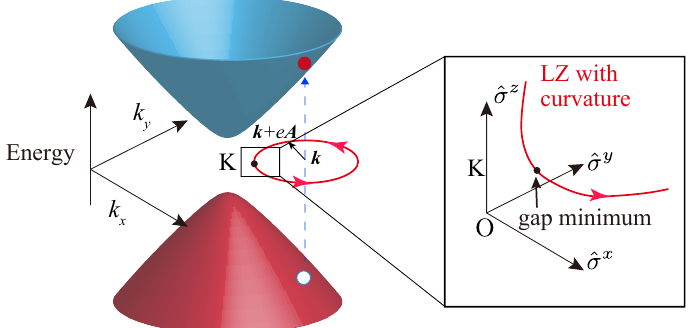
Figure 2: Mapping from the twisted Schwinger effect to the twisted Landau Zener problem: In rotating electric fields, the electron-hole pairs have a covariant momen- tum k + e A ( t ) which performs a rotating motion in the momentum space. During this dynamics, the energy gap minimizes when k + e A ( t ) is closest to the K -point. We focus on this gap minimum point as depicted in the right box. By performing a quadratic expansion of the Hamiltonian ˆ H ( t ) in the time variable ( q = Ω t ) around the gap minimum time, we obtain the twisted Landau Zener problem defined by Eq.